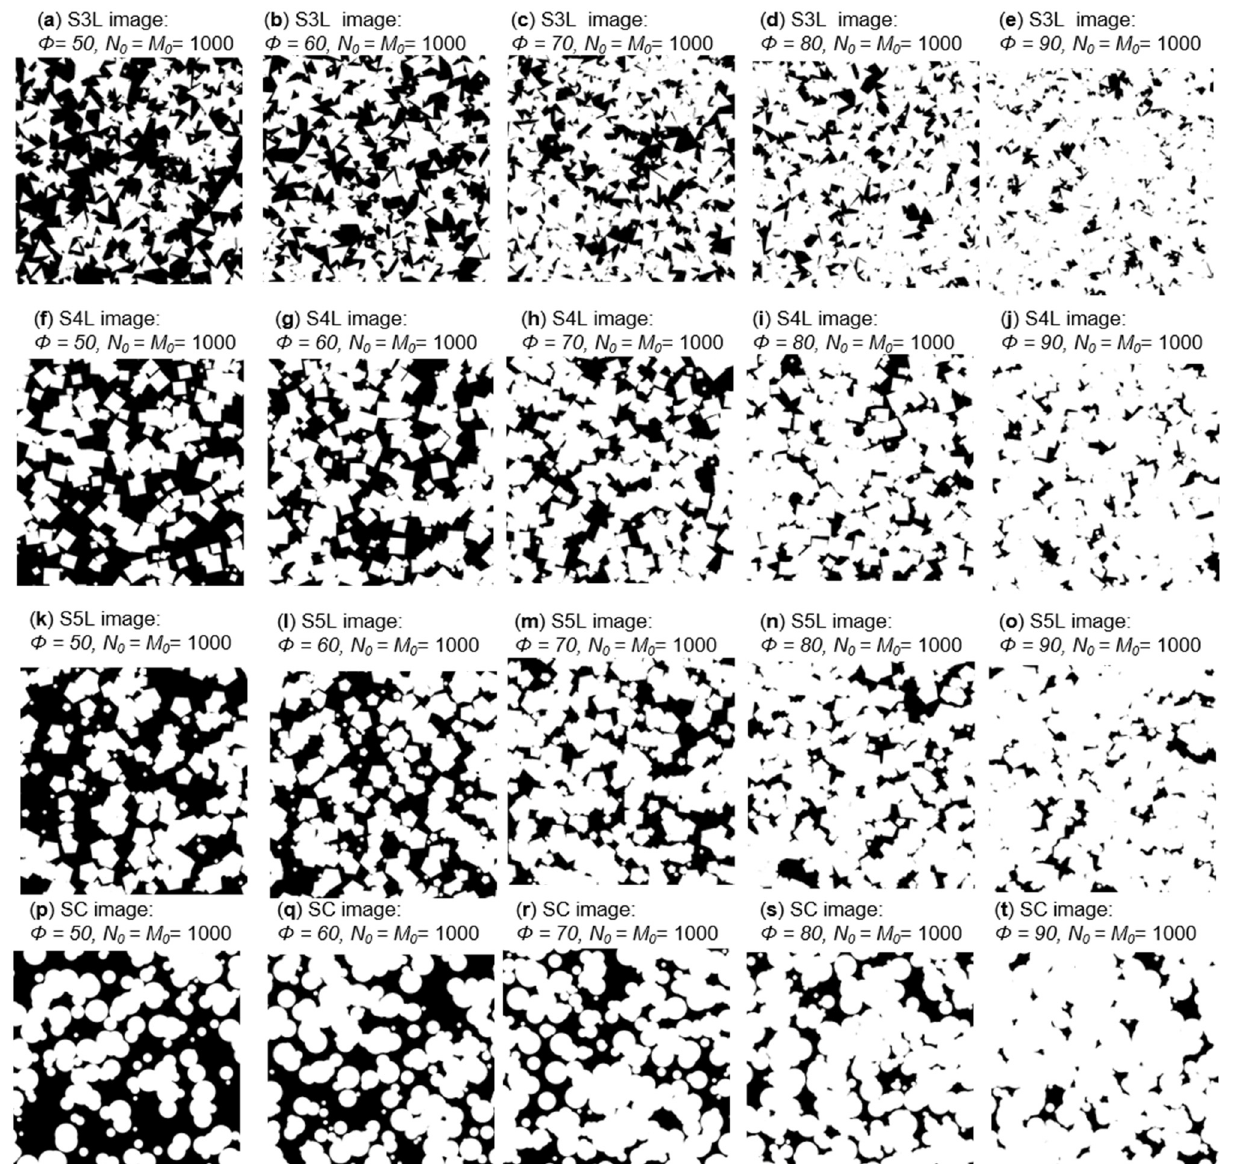
Figure 7. Constructed synthetic media for different geometry of agglomerate phase in a surface fraction range of 50% to 90%. ( a – e ) is for S3L image, ( f – j ) is for S4L image, ( k – o ) is for S5L image and ( p – t ) is for SC image.